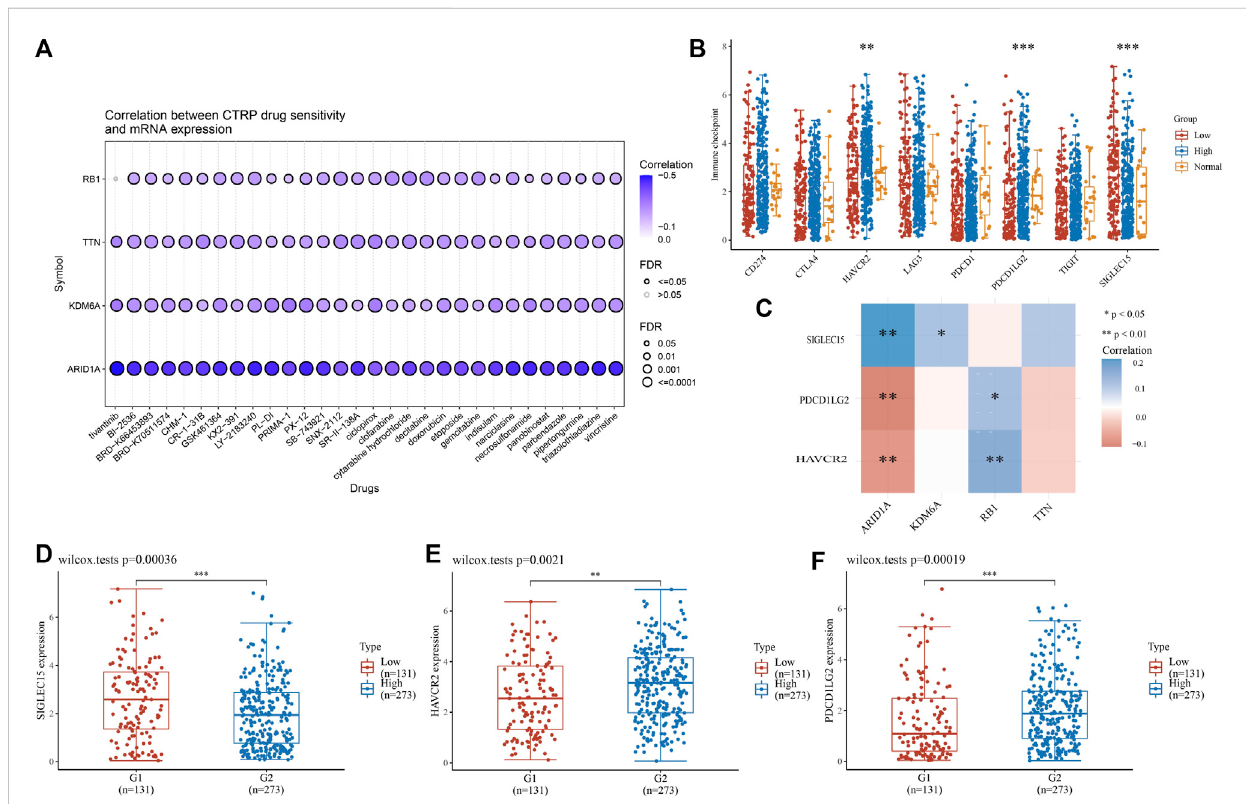
FIGURE 10 High-mutationgenesareassociatedwithdrugsensitivityandimmunecheckpointsanalysis (A) Drug-sensitivityanalysisoffourhigh-mutationgenes in BLCA (B) Different expressions of immune-checkpoints in low-, high-grade and normal adjacent tissues in BLCA (C) The correlation analysis between four high-mutation genes and three immune-checkpoints genes (D – F) The expression of three immune-checkpoints genes in low- and high-grade